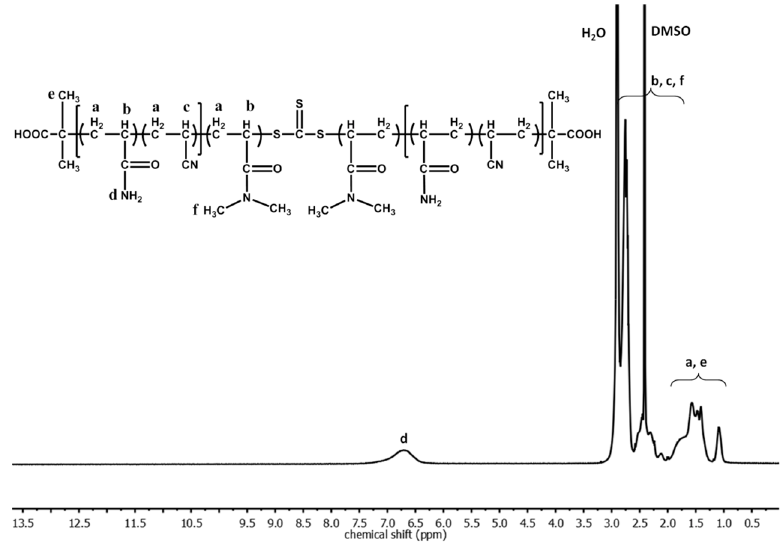
Figure 2. 1 H NMR Spectrum of the triblock copolymer P(AAm– co –AN)– b –PDMA– b –P(AAm– co –AN) in d 6 -DMSO.